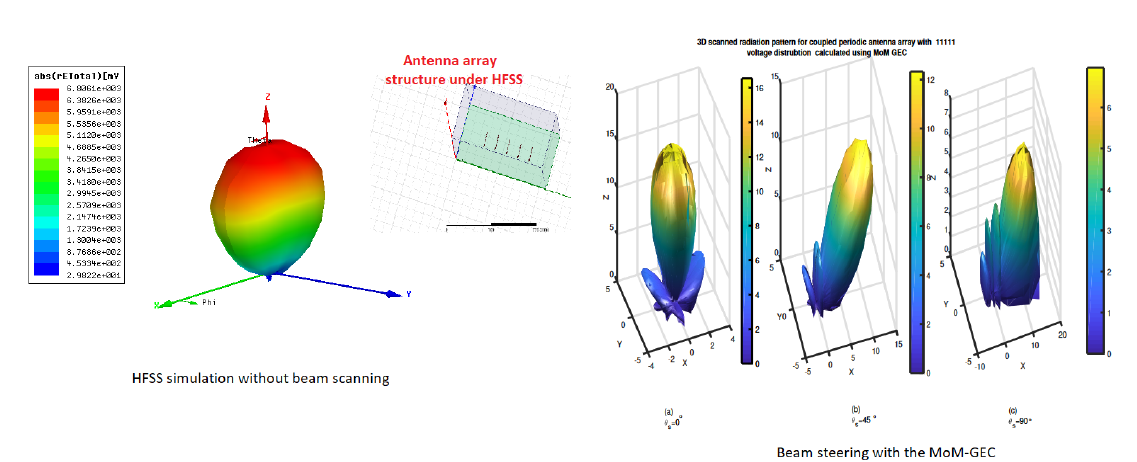
Figure 26. Validation of the radiation pattern obtained using the MoM-GEC and HFSS tools for a coupled periodic antenna array with 5 elements and d x ≈ λ 0